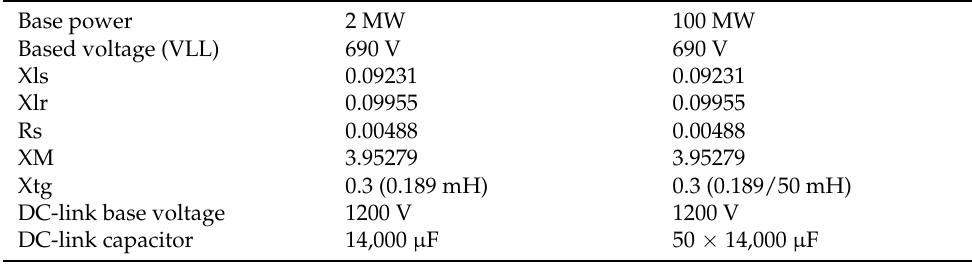
Table A1. Parameters of the single line diagram of the DFIG-based